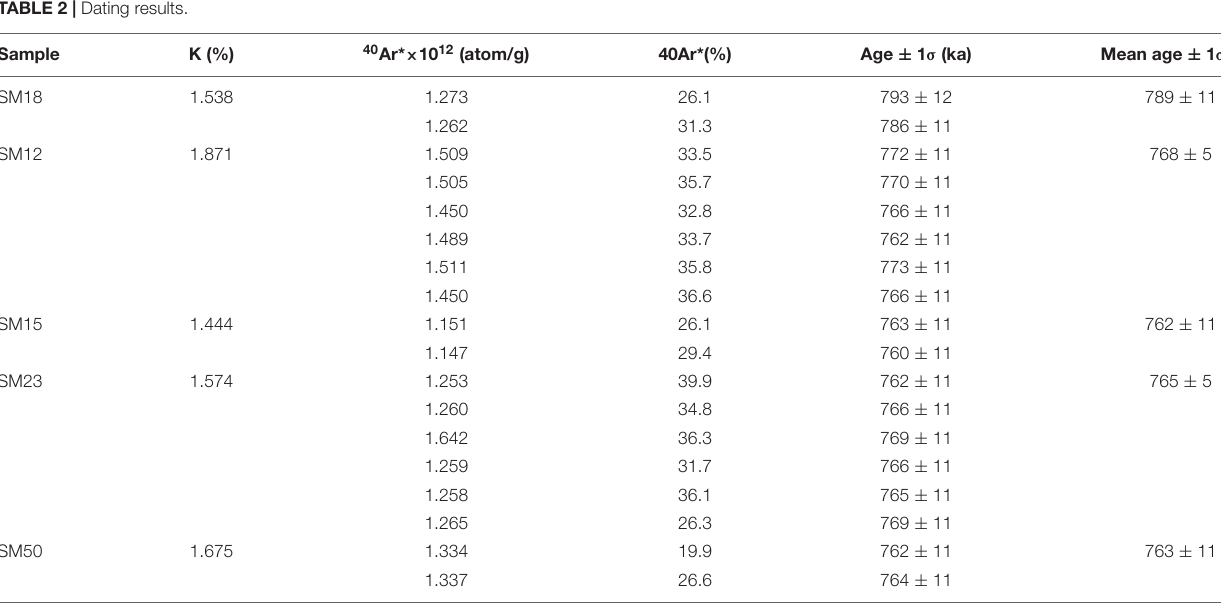
FIGURE 5 | Mean Declination (A) , inclination (B) , paleolatitude of virtual geomagnetic poles (C) and relative paleointensity (D) of each flow plotted by order of appearance in the sequence. Arrow heads indicate flows with an age obtained in this study and/or from Johnson et al. (1998) (SM02). TABLE 2 | Dating